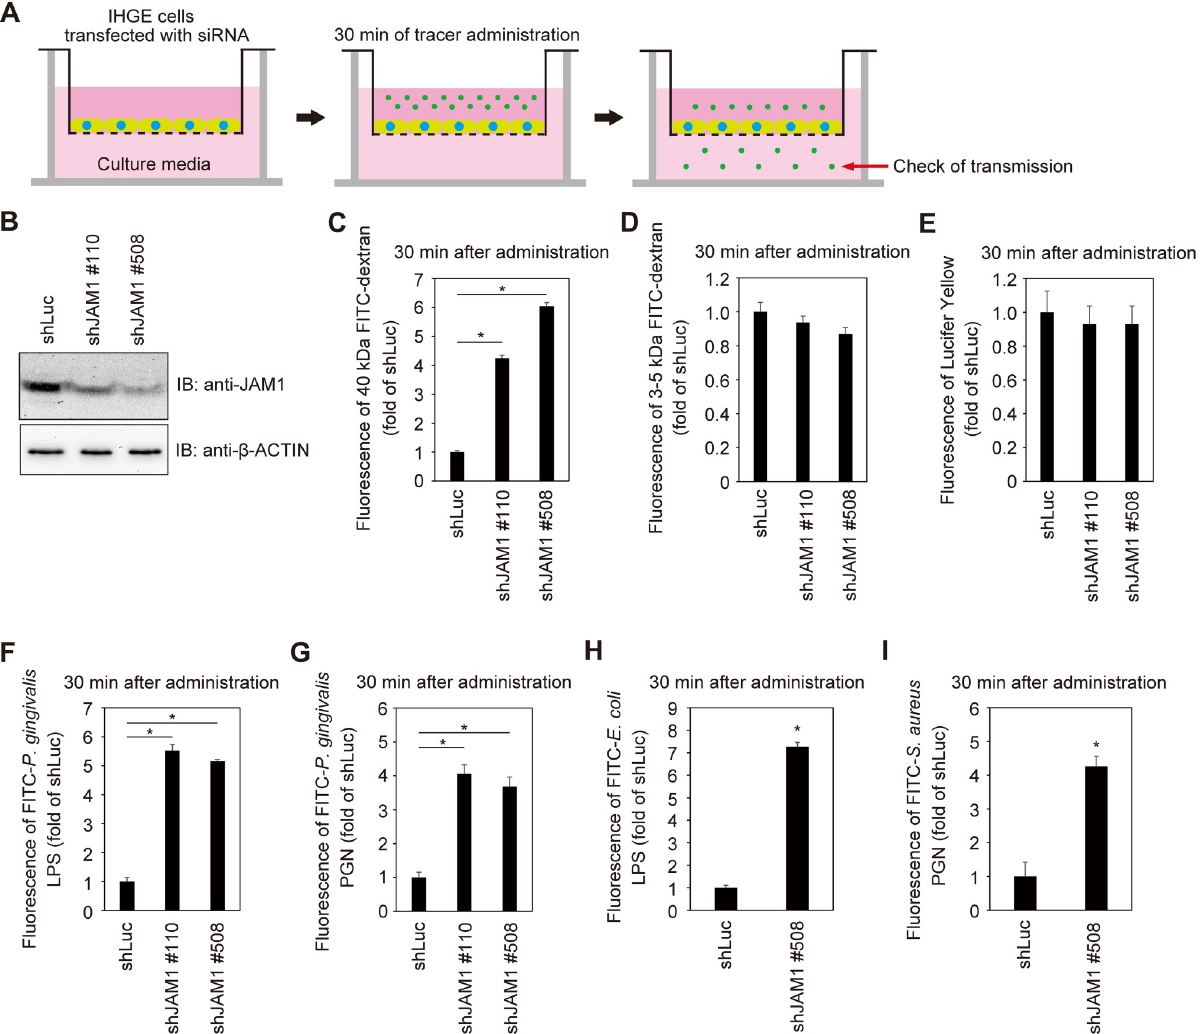
Fig 6. JAM1 is required for epithelial barrier function of IHGE cells. (A) Schematic image of the culture insert system. Monolayer of IHGE cells stably expressing shLuc, shJAM1 #110, or shJAM1 #508 were cultured in culture inserts. FITC-labeled tracer was added to culture media in the upper compartment. Following 30 min of incubation, the transmission of tracer from the upper compartment to the lower compartment was analyzed by spectrometry. (B) JAM1 expression in IHGE cells stably expressing shLuc, shJAM1 #110, or shJAM1 #508 was analyzed by immunoblotting with the indicated antibodies. (C – I) Permeability to 40 kDa FITC-dextran (C), 3–5 kDa FITC-dextran (D), 0.5 kDa Lucifer Yellow (E), FITC– P . gingivalis LPS (F), FITC– P . gingivalis PGN (G), FITC– E . coli LPS (H), or FITC– S . aureus PGN (I) in IHGE cells expressing shLuc and shJAM1. Results are expressed as fold change relative to cells expressing shLuc and are the means ± SD of eight technical replicates. � , p < 0.05, two-tailed Dunnett’s test (C-G) or two- tailed t test (H,